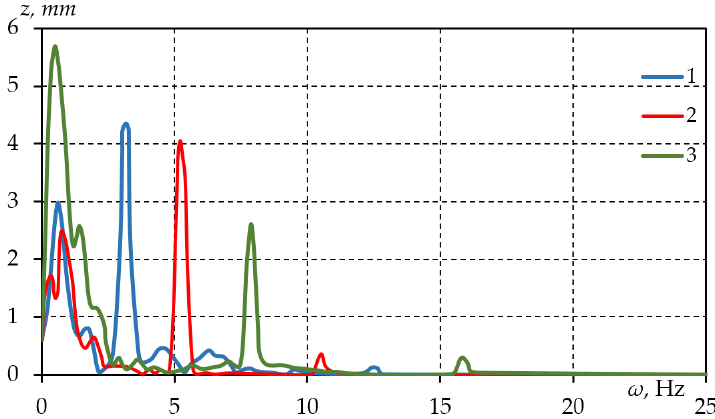
Figure 16. Spectrum of vehicle body displacements at different wheel rotational speeds: 1 — gear I; 2 — gear II; 3 — gear III.